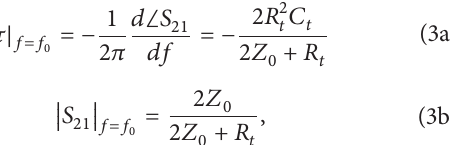
the required amount of NGD time at the operating frequency is obtained by connecting the external